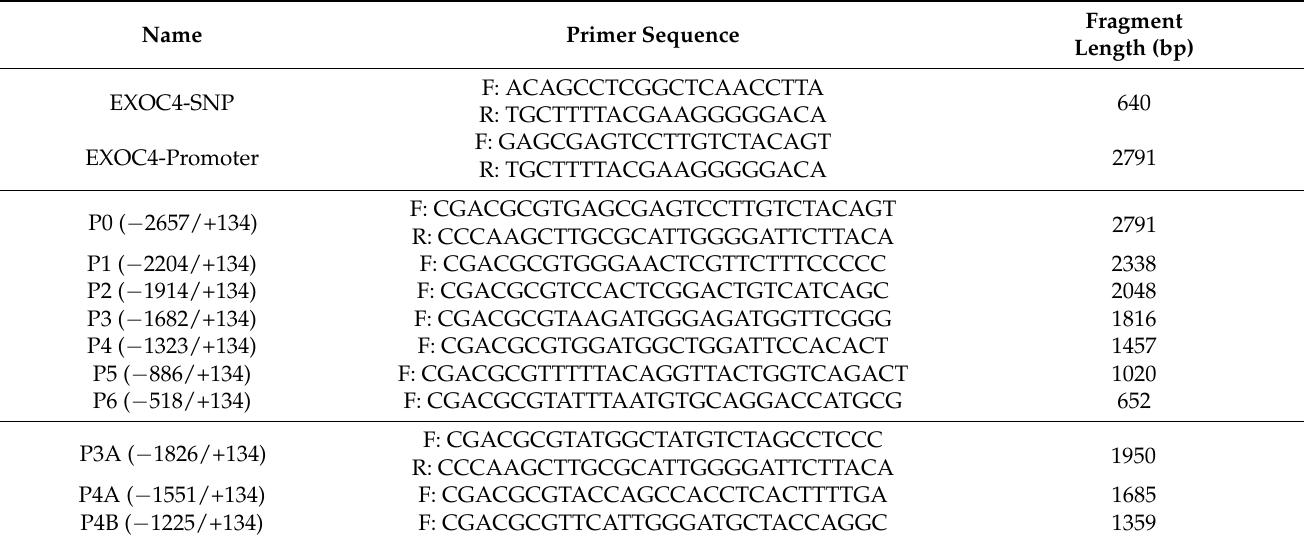
Table 1. Primers used in this study. SNP: single nucleotide